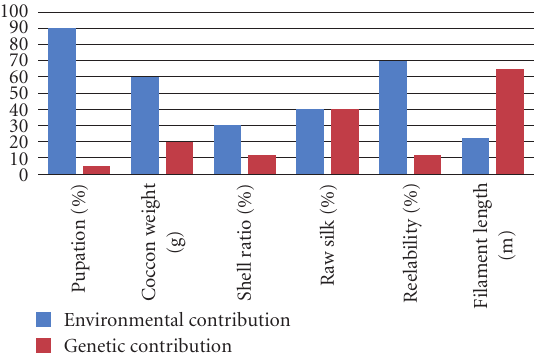
Figure 2: Environmental and genetic contribution to various economic traits of silkworm, Bomby mori L.